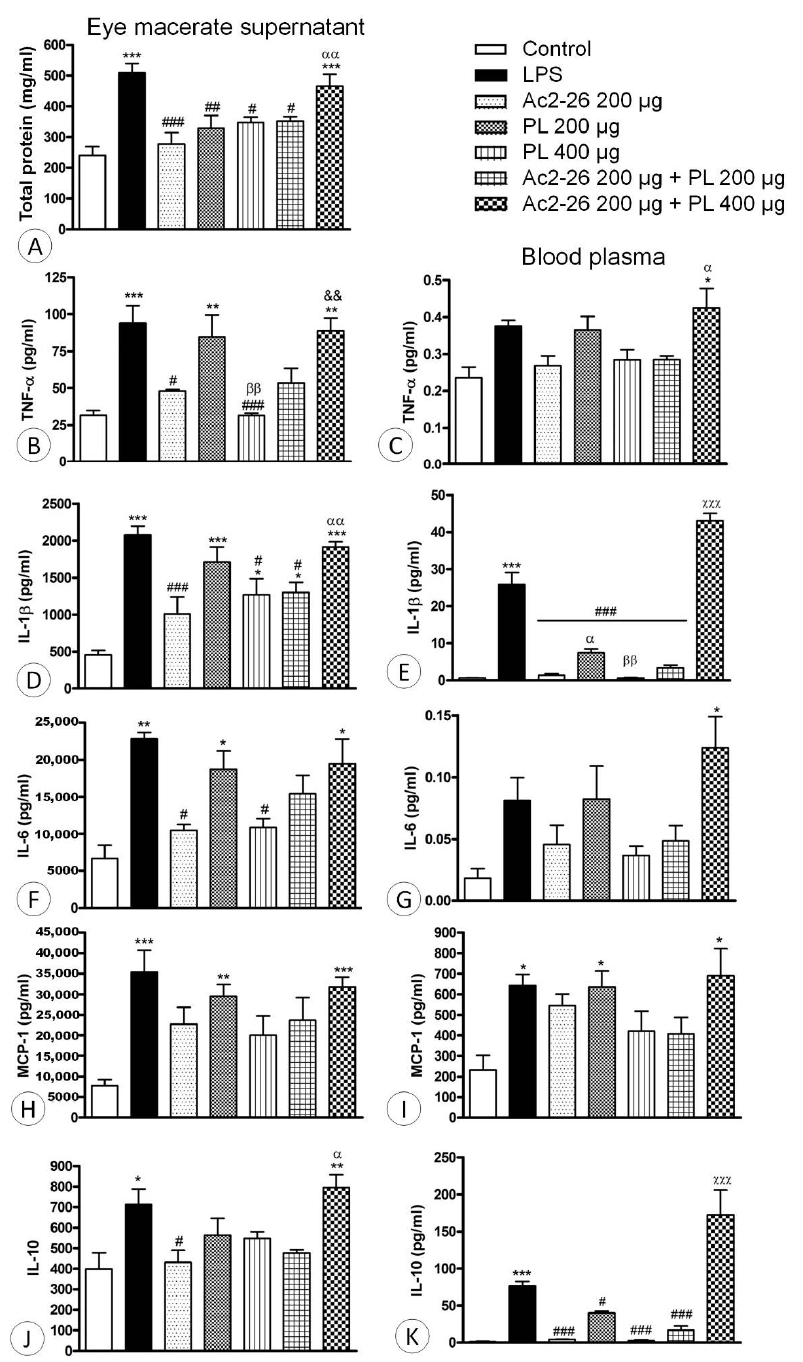
Figure 4. Effects of peptide Ac2-26 and PL, administered singly or in combination, on EIU. Levels of total proteins in supernatants after maceration of ocular tissues ( A ) and dosages of anti-inflammatory mediators TNF- α ( B , C ), IL-1 β ( D , E ), IL-6 ( F , G ), and MCP-1 ( H , I ) and proinflammatory cytokine IL-10 ( J , K ) in the macerated eye supernatant and blood plasma. Data expressed as mean ± SEM of mg of proteins/mL and pg of cytokines/mL of control, untreated (LPS), and treated (Ac2-26 200 µ g, PL 200 µ g, PL 400 µ g, Ac2-26 + PL 200 µ g, and Ac2-26 + PL 400 µ g) rats ( n = 10 animals/group). *** p < 0.001, ** p < 0.01, and * p < 0.05 versus control; # p < 0.05, ## p < 0.01, and ### p < 0.001 versus LPS; αα p < 0.01 and α p < 0.05 versus Ac2-26 200 µ g; ββ p < 0.01 versus PL 200 µ g; && p < 0.01 versus PL 400 µ g; and χχχ p < 0.001 versus all other